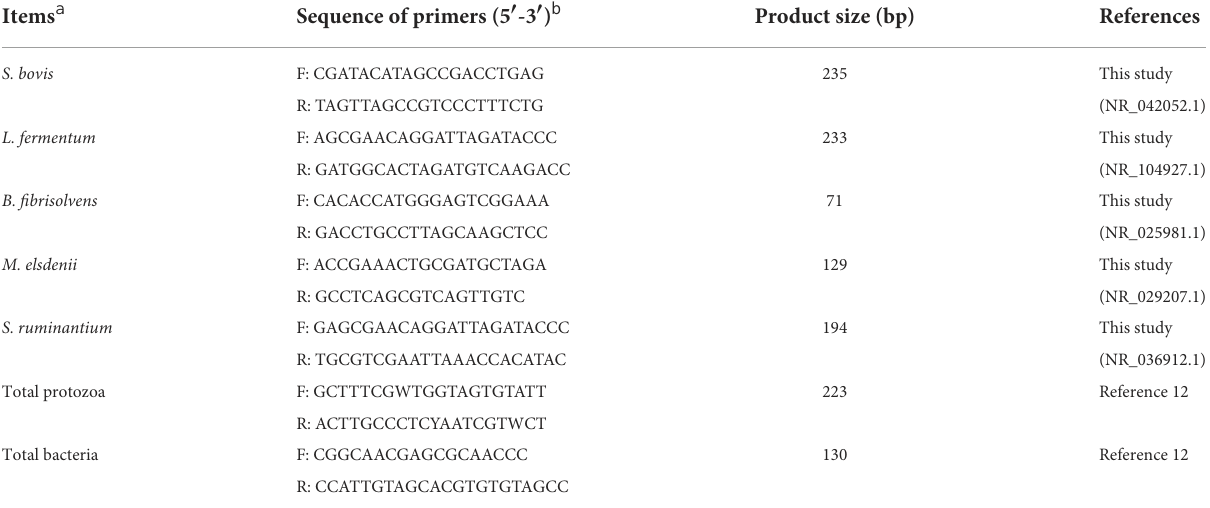
TABLE 3 Primer sequences of rumen microbiota for RT-qPCR.